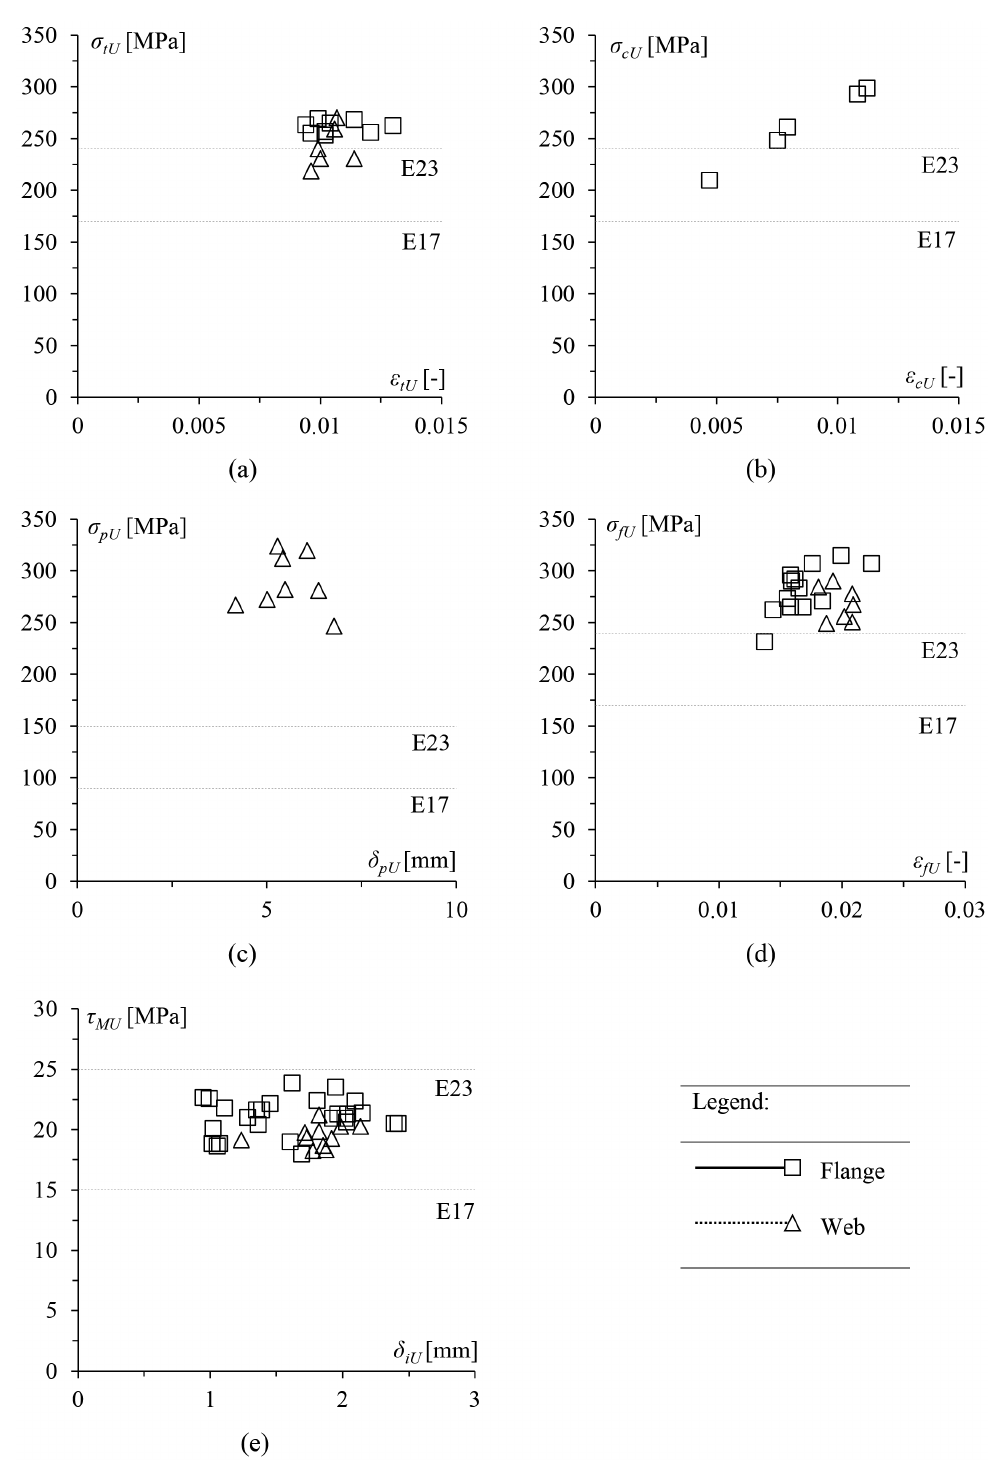
Figure 6. Obtained GFRP element limit results and their general structural classification: (a) direct tension, (b) direct compression, (c) pin-bearing pushed-out, (d) two-point flexural bending and (e) interlaminar